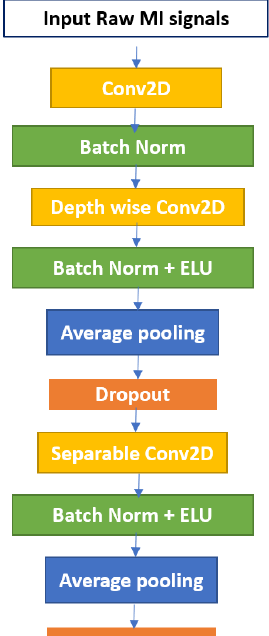
Figure 1. The EEGNet Block.